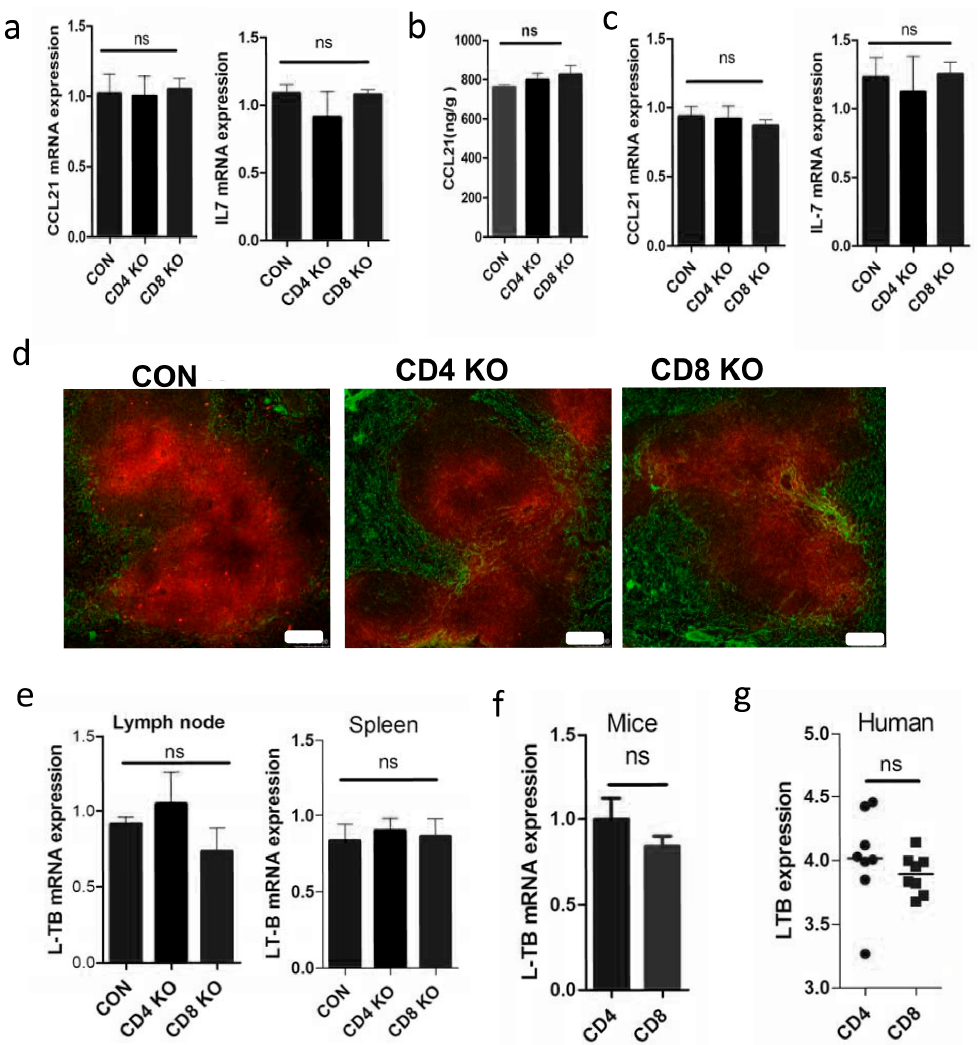
Figure 3. Lymph cytokines are not significantly different without CD4 + T cells. ( a ) Cytokine expression in lymph nodes of wild-type, knockout mice lacking CD4 + T or CD8 + T cells (CD4KO or CD8KO) as quantified by RT-qPCR and ( b ) detected by ELISA in tissue homogenates; ( c ) cytokine expression in spleens of wild-type, CD4KO, and CD8KO mice as quantified by RT-qPCR; ( d ) spleen cryostat sections were stained for CCL21 (red) and ER-TR7 (green; scale bar: 75 µm); ( e ) LT- β expression in lymph nodes and spleens of wild-type, CD4KO, and CD8KO mice; ( f ) mouse CD4 + and CD8 + T cells as determined by RT-qPCR; and ( g ) LT- β expression as determined by microarray analysis of circulating CD4 + and CD8 + T cells as isolated from eight healthy people. ns indicates not significant.